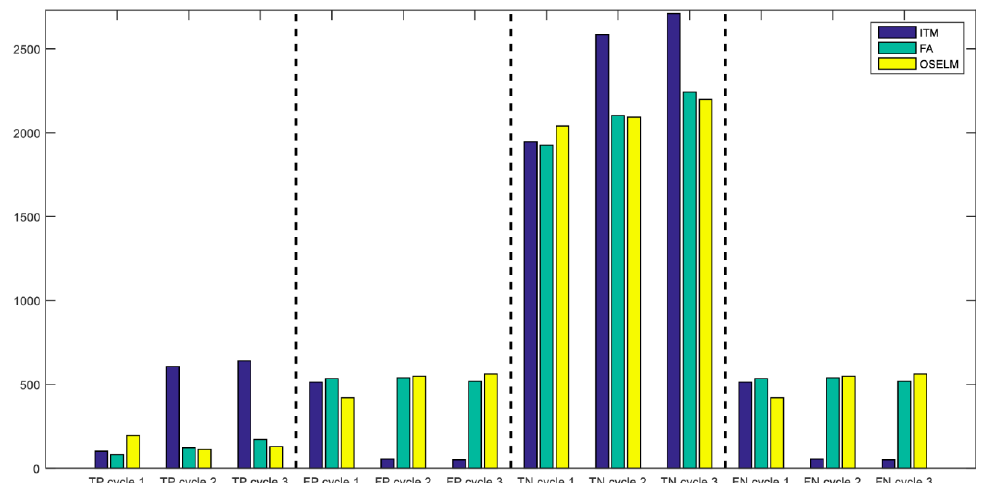
Figure 10. Classification measures with respect to cycles for the three models with the TampereU dataset.